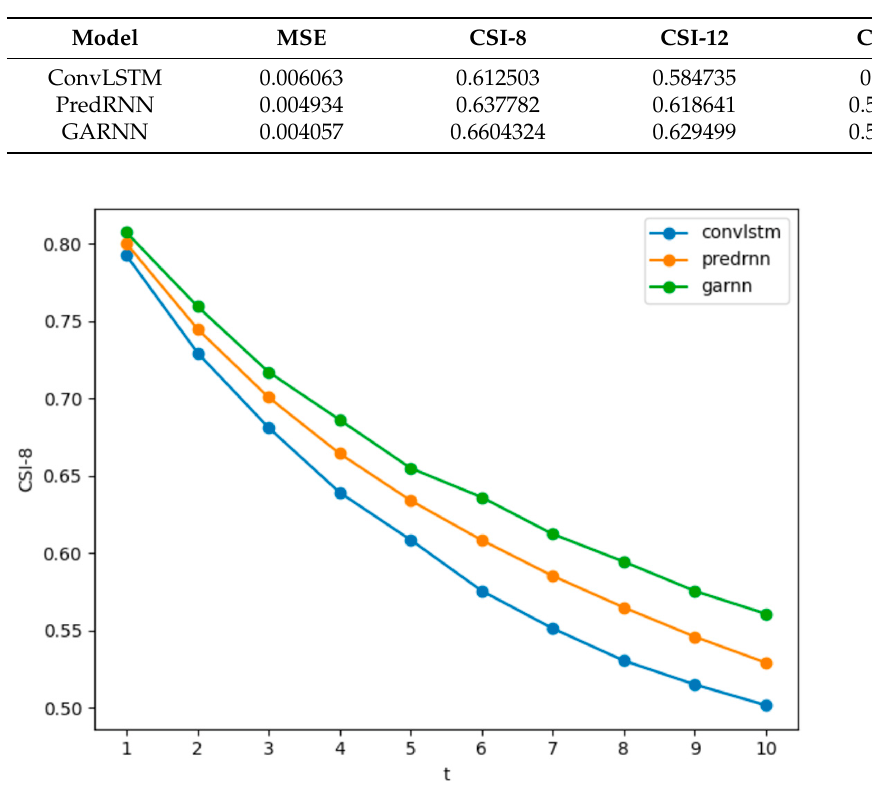
Figure 11. Frame-wise comparison of GARNN, ConvLSTM, and PredRNN at 8 dBZ